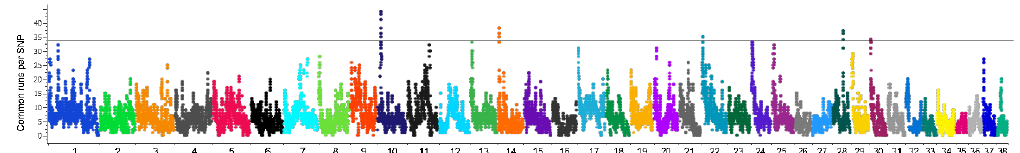
Figure 8. Graph inferred by TreeMix for the Istrian shorthaired hound, 14 dog breeds, and Grey wolf as root, allowing eight migration events. Migration arrows are colored according to their weight. Horizontal branch lengths are proportional to the amount of genetic drift that occurred on the branch.